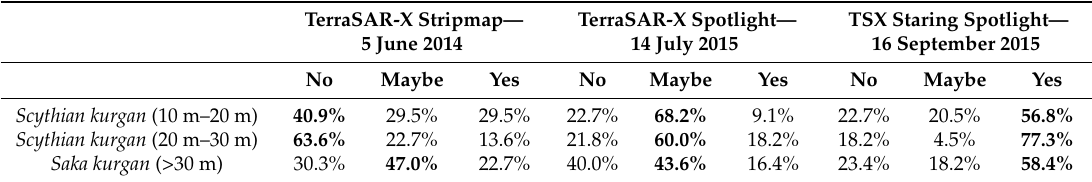
Table 3. Aggregated voting results from the test group with 11 members. The majority votes are marked in